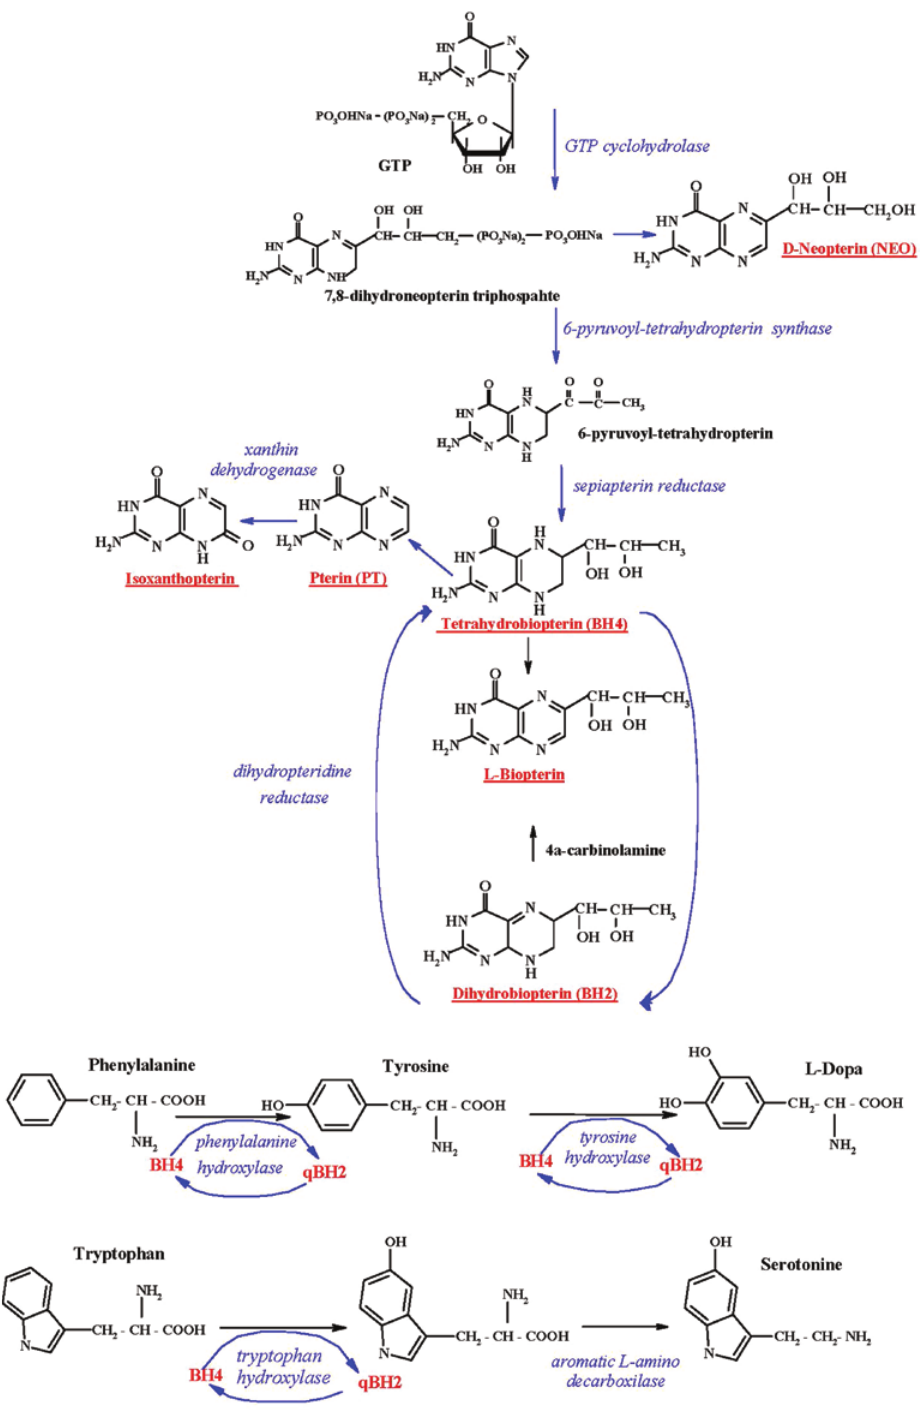
Figure 1: Pteridine metabolism and neurotransmitter